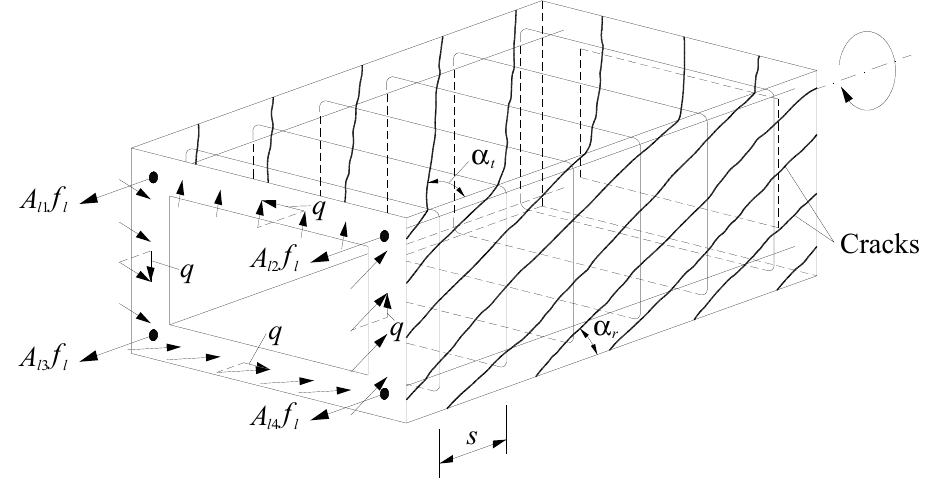
Figure 2. RC hollow beam element [18].